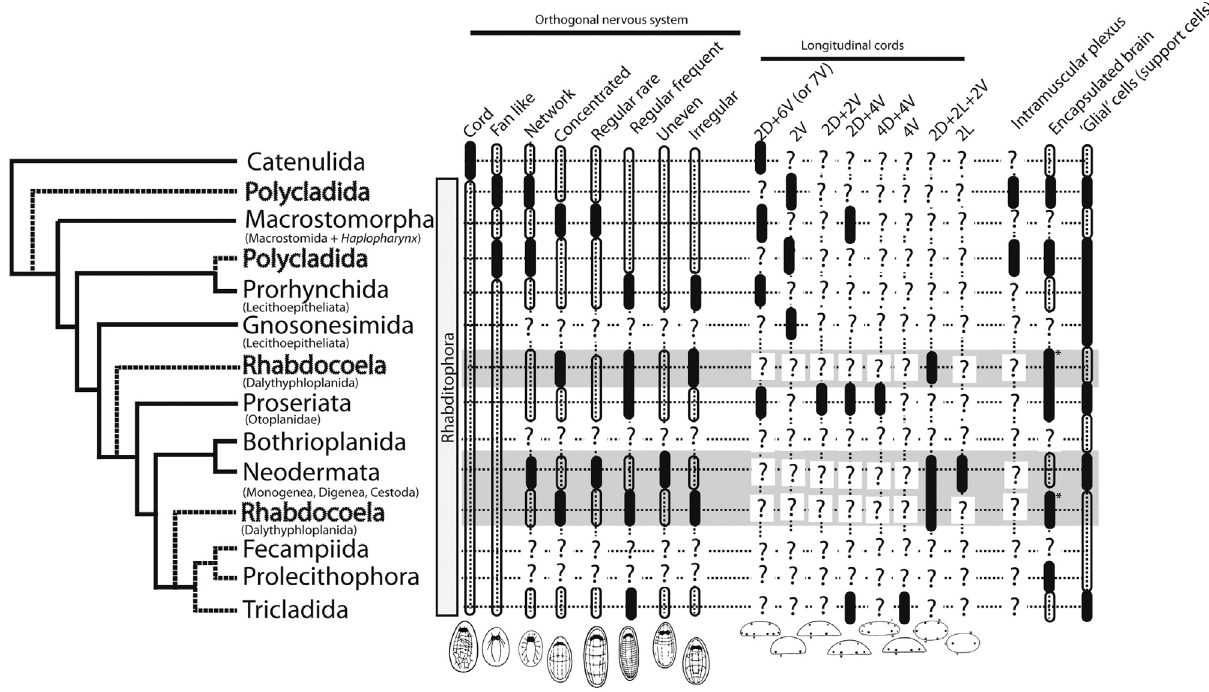
Figure 7 - Evolution of the nervous system in flatworms. Important characters/features of the nervous system of platyhelminths are reconstructed into most recent phylogenies (Laumer and Giribet, 2014; Laumer et al. , 2015; Egger et al. , 2015). Groups with conflicting phylogenetic positions are in dashes; and alternative positions are shown. Filled ellipses represent presence of the character, empty ellipses represent absence of the character, whereas question marks (?) represent lack of knowledge of the particular character for the group. Shaded box represent parasitic groups with the greatest diversity of orthogonal organization types. Cartoons were adapted from Reuter and Gustafsson (1995). References used in the reconstruction: Bailly et al. (2013); Bockerman et al. (1994); Fernandes et al. (2003); Hyman (1941, 1951); Mäntylä et al. (1998a, b); Karling (1968); Kotikova et al. (2002); Reisinger (1968); Reuter and Gustafsson (1995); Reuter et al. (1996); Rieger et al. (1991); Sluys (1989); Steinböck and Reisinger (1924); Steinböck (1927); Timoshkin (1991); Von Graff (1899). * Exception: no capsule was found in the rhabdocoel Strongylostoma simplex (Bedini and Lanfranchi,